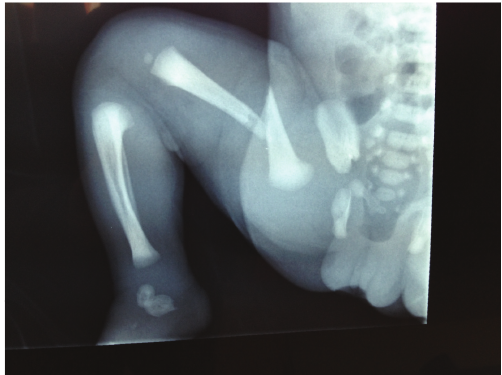
Figure 1: Rx showing right femur fracture.